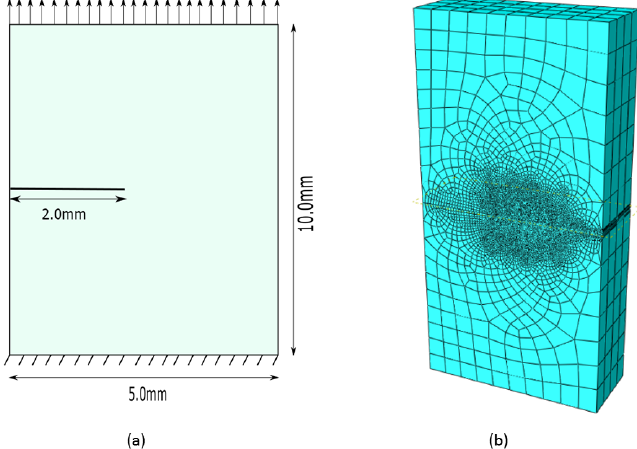
Figure 3. A single edge notched tensile specimen: ( a ) representational 2D geometry; thickness = 2.0 mm; and ( b ) hexahedral mesh with smaller element size near the expected propagation